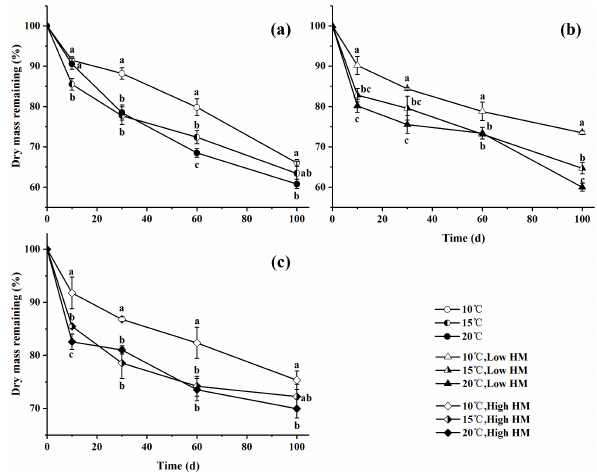
Figure 2: Mass remaining of Typha incubated at three temperatures and two heavy metal (HM) levels for 100 days. Legend: (a) control treatment; (b) three temperatures and low heavy metal levels; (c) three temperatures and high heavy metal levels. Different lowercase letters on the top of the bars denote significant differences among different treatments at the same sampling time (n=3, P <